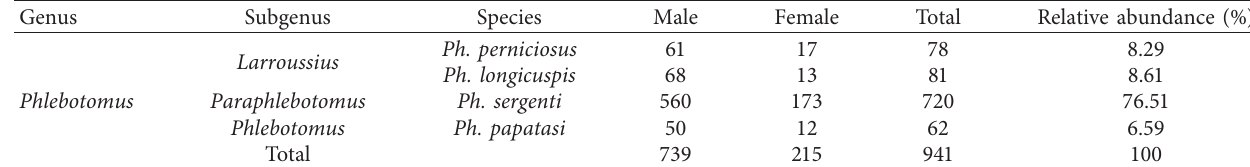
Table 1: Presence and relative abundance of species in Meknes